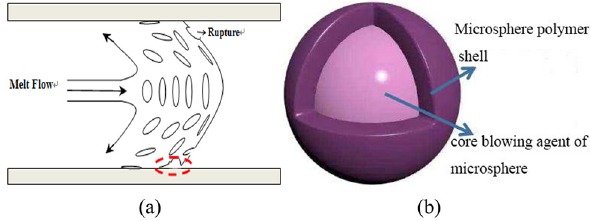
Figure 9: E ff ect of surface quality of micro foamed ABS material: ( a ) spring surge e ff ect and ( b ) “ core – shell ” structure of